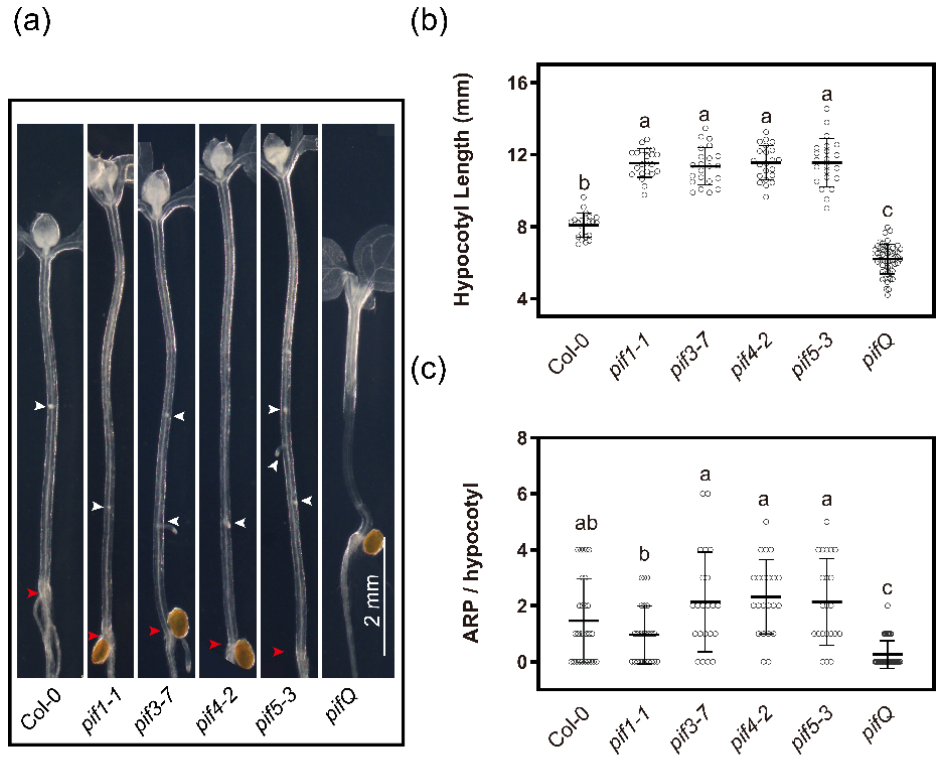
Figure 6. Hypocotyl elongation and rooting response of Phytochrome-Interacting Factor (PIF) mutants. ( a ) Representative images of WT (Col-0), pif1-1 (Col-0), pif3-7 (Col-0), pif4-2 (Col-0), pif 5-3 (Col-0) and pifQ (Col-0) cleared hypocotyl grown in the light for 4 days after 3 days etiolation. White arrowheads indicate ARP, the red arrowhead points to the hypocotyl root junction. ( b , c ) Quantification of the ( b ) hypocotyl length and ( c ) ARP of the seedlings as in ( a ). The data in ( b , c ) are means ± SD obtained from mutant lines (Col-0, n = 27 ; pif1-1 , n = 24; pif3-7 , n = 22; pif 4-2 , n = 22; pif 5-3, n = 22 and pifQ, n = 4 6 ). Different letters indicate a significant difference at p ≤ 0.05 (ANOVA and LSD post hoc analysis). Scale bar: 2 mm. All images were taken at the same magnification.